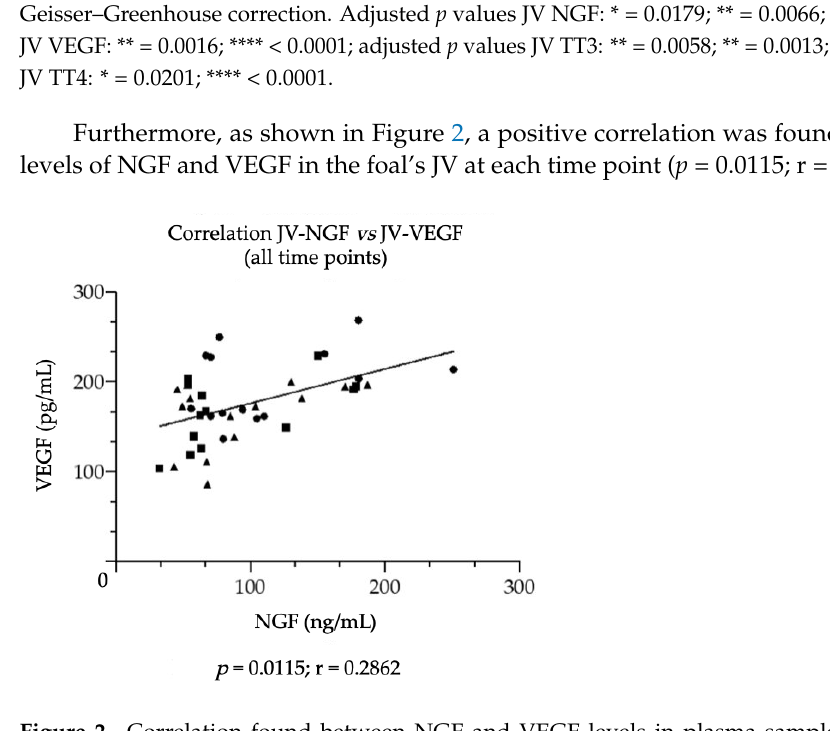
Figure 2. Correlation found between NGF and VEGF levels in plasma samples obtained from foal’s jugular vein at three consecutive time points (round points T0: birth; square points T24: 24 h from birth; triangular points T72: 72 h from birth). Statistical analysis: non-parametric Spearman correlation. p = 0.0015; r = 0.2862.